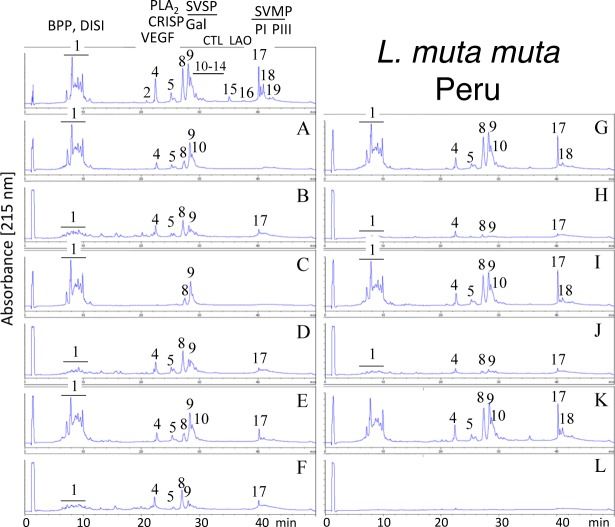
Immunoaffinity chromatography-based antivenomic analysis of the immunoreactivity of polyspecific and monospecific antivenoms towards the venom of L. muta muta from Peru.Panels display reverse-phase separations of whole venom components, and non-retained (A, C, E, G, and I) and the retained (B, D, F, H, and J) fractions recovered, respectively, from the affinity columns of immobilized BCL, BL, AL, AB, and AC antivenoms. Panels K and L, non-retained and retained venom fractions by immobilized equine control immunoglobulins. CRISP, cysteine-rich secretory protein; CTL, C-type lectin-like; other acronyms as in the legend of Fig 2.